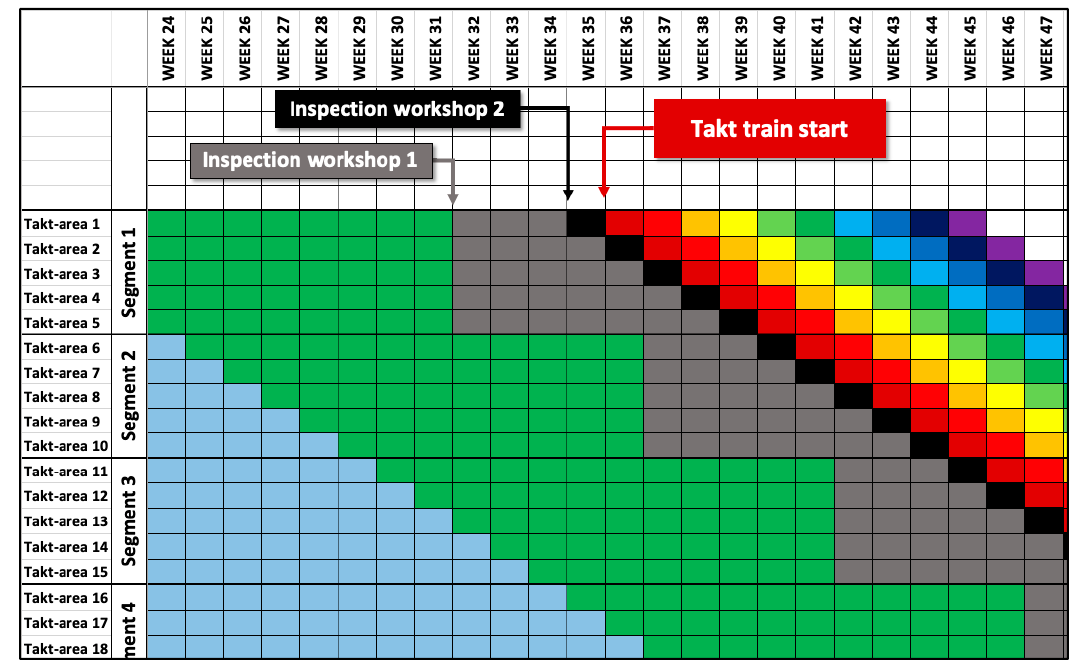
Figure 4. Two phases of inspections for HVAC construction documents.